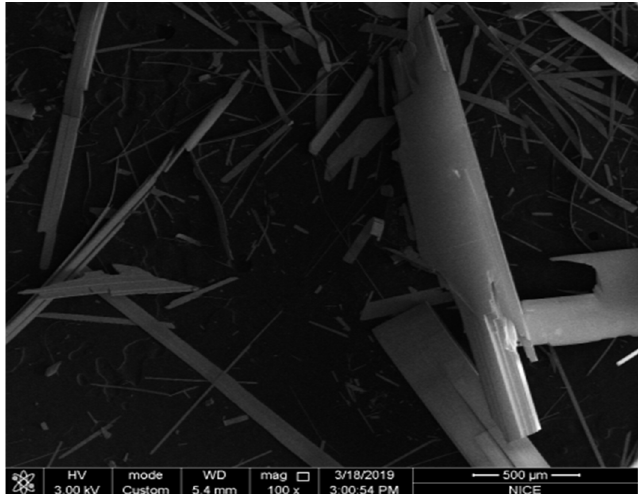
Figure 4. SEM image of the sublimation crystallization product.